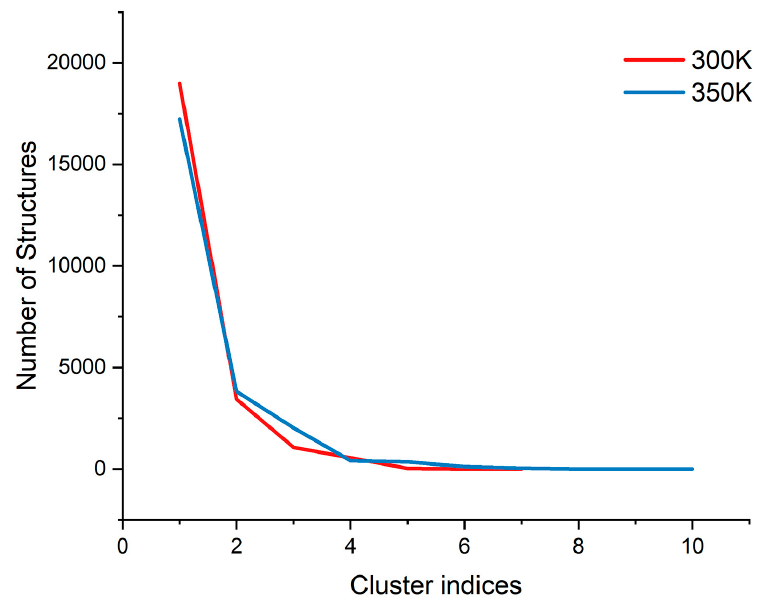
Figure A3. The trend of the number of structures with the cluster indices at each temperature.